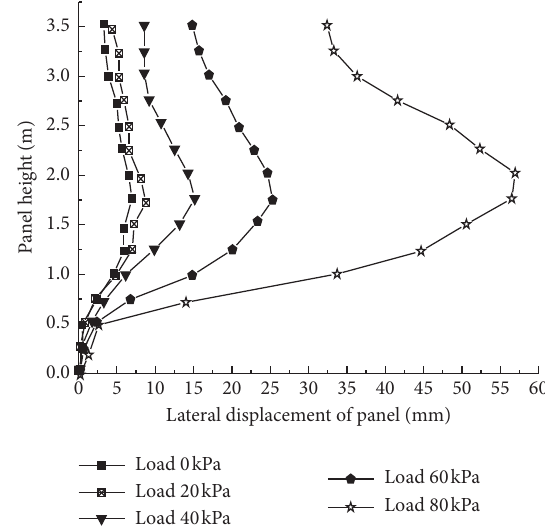
Figure 3: Lateral displacement and deformation of wall panel under different loads.